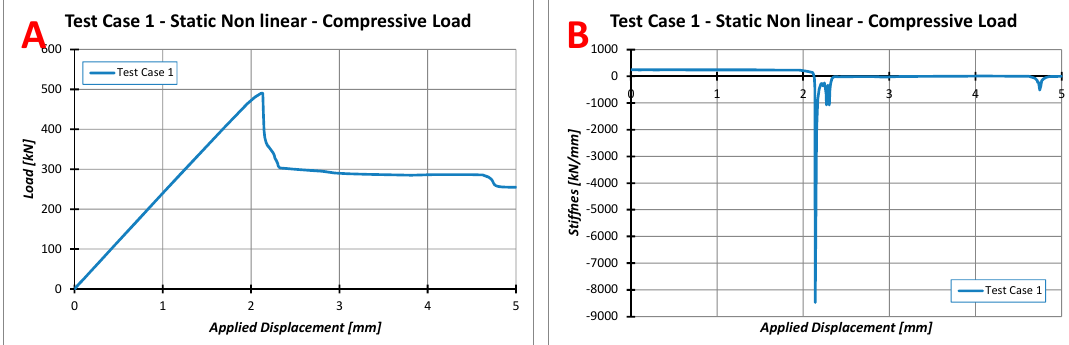
Figure 17. Test case 1—Non-linear analysis. ( A ) Load—displacement curve. ( B ) Stiffness— displacement curve.